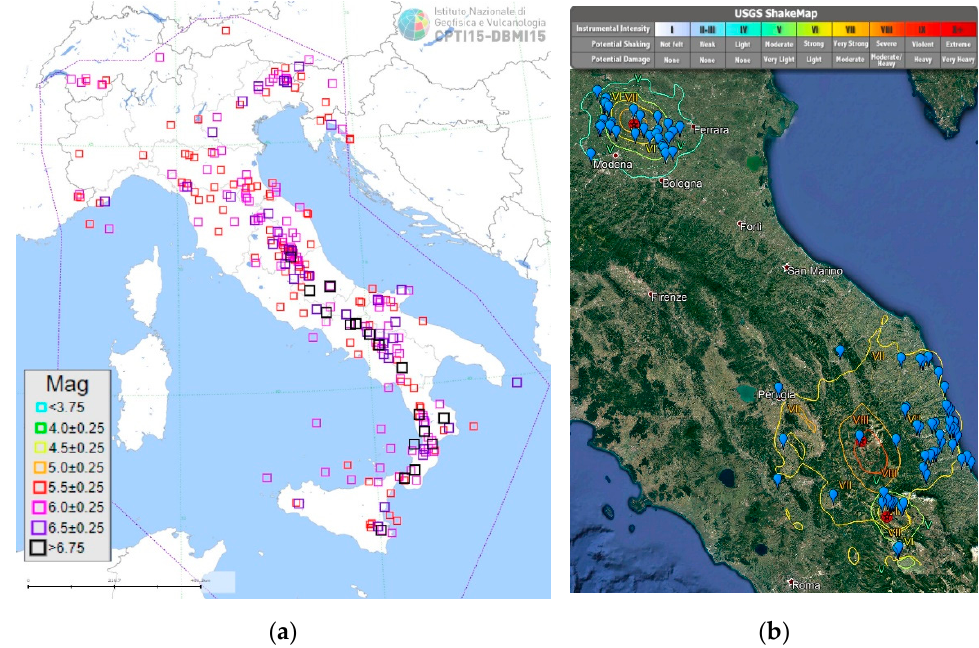
Figure 1. ( a ) Epicenters of the Italian earthquakes with moment magnitude greater than 5.5 in the period 1000–2014 and ( b ) sample distribution in Italy as respect to the intensity contours of Abruzzo 2009, Emilia 2012, and central Italy 2016 earthquakes.